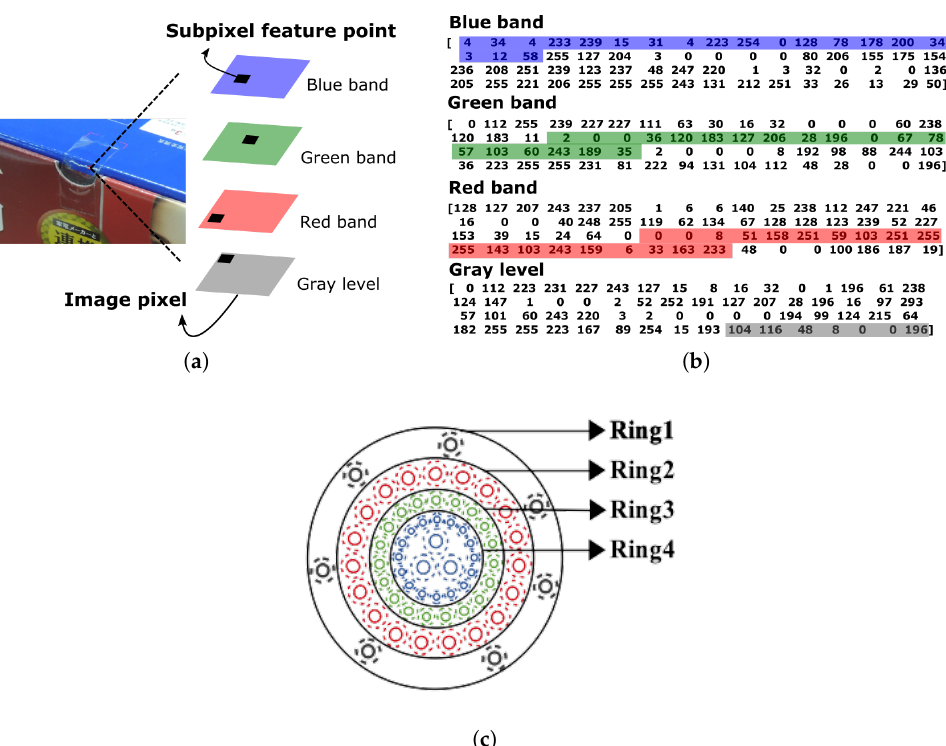
Figure 4. Synthesizing colored feature descriptors for the most representative keypoints. ( a ) Detecting the most representative keypoints, ( b ) extracting color descriptors, and ( c ) inserting synthetic-colored feature descriptors into the ISR pattern with R-G-B color